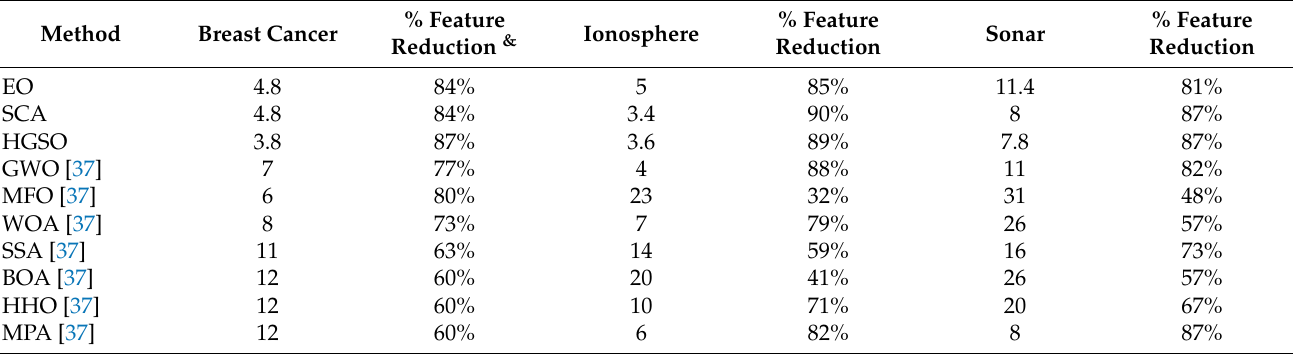
Table 8. Comparison of AFS with literature